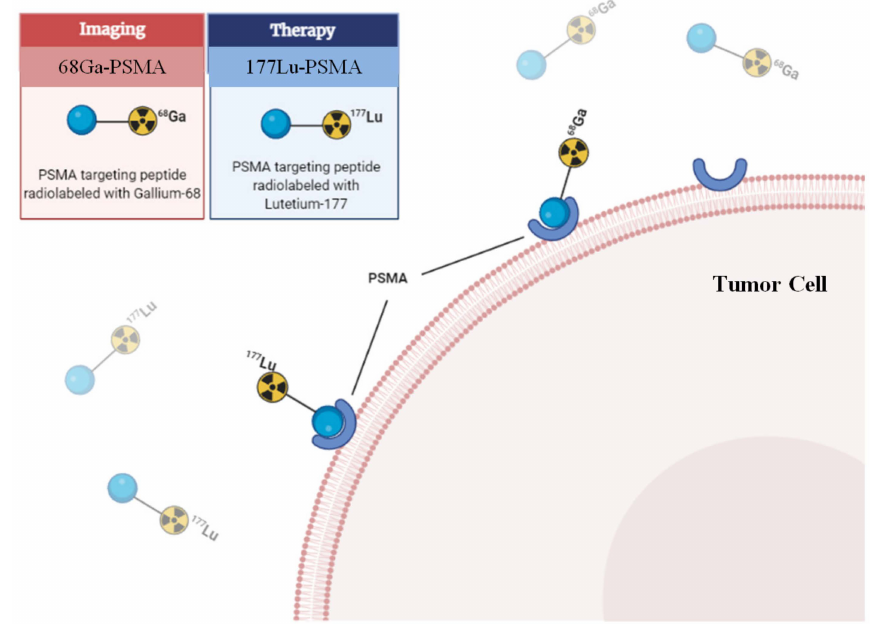
Figure 1. PSMA radioligand and receptor interaction. 68Ga: 68Gallium; 177Lu: